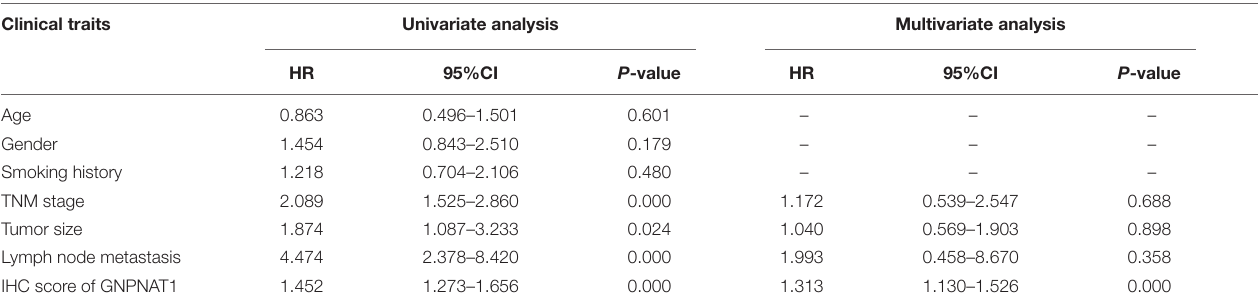
FIGURE 4 | Association of GNPNAT1 expression with clinical features in validation set, including TNM stage (A) , tumor size (B) , and lymph node metastasis status (C) . The Kaplan–Meier curves about the correlation between GNPNAT1 expression and overall survival (D) and disease-free survival (E) . ** P < 0.01 and **** P < 0.0001, ns: insignificant). TABLE 4 | The Cox regression analysis among clinical traits and OS in validation